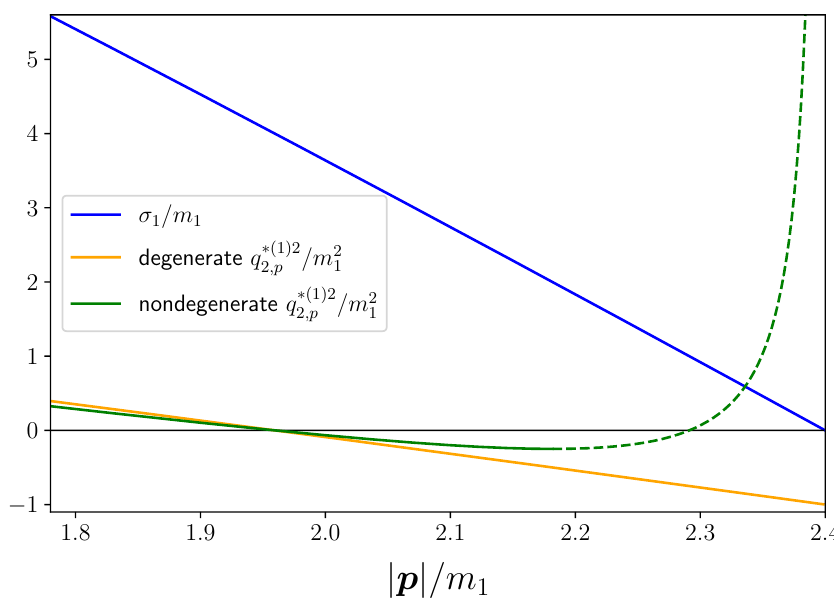
(solid blue) and q ∗ (1)2 (solid orange, and green solid/dashed) Figure 1. Dependence of σ 1 /m 2 /m 2 1 1 2 ,p on | p | /m for E = 5 m and P = 0 . Here p is the momentum of the spectator, which has flavor 1 . 1 1 The initial proposal for the cutoff function, given in eq. (2.22), vanishes at the point where σ = 0 , i which corresponds to the maximum value of | p | /m used. The two curves for q ∗ (1)2 are for /m 2 1 1 2 ,p m 2 = m 3 = m 1 (orange curve) and for m 2 = 0 . 5 m 1 , m 3 = 1 . 5 m 1 (green), respectively. The latter curve is shown as dashed after the minimum, which occurs at the position of the left-hand cut, as discussed in the